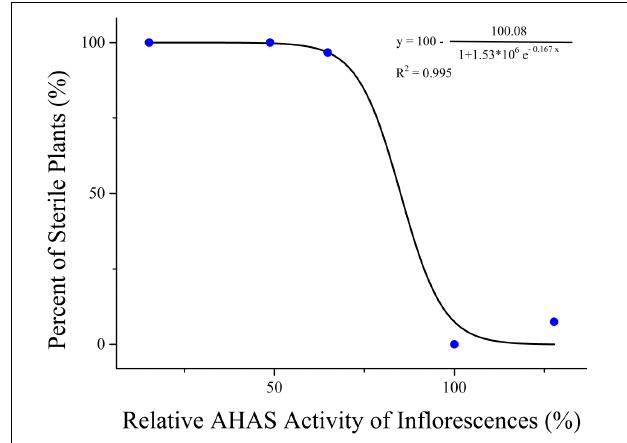
FIGURE 3 | Correlation analysis of inflorescence AHAS activity and male sterility in rapeseed ZS9